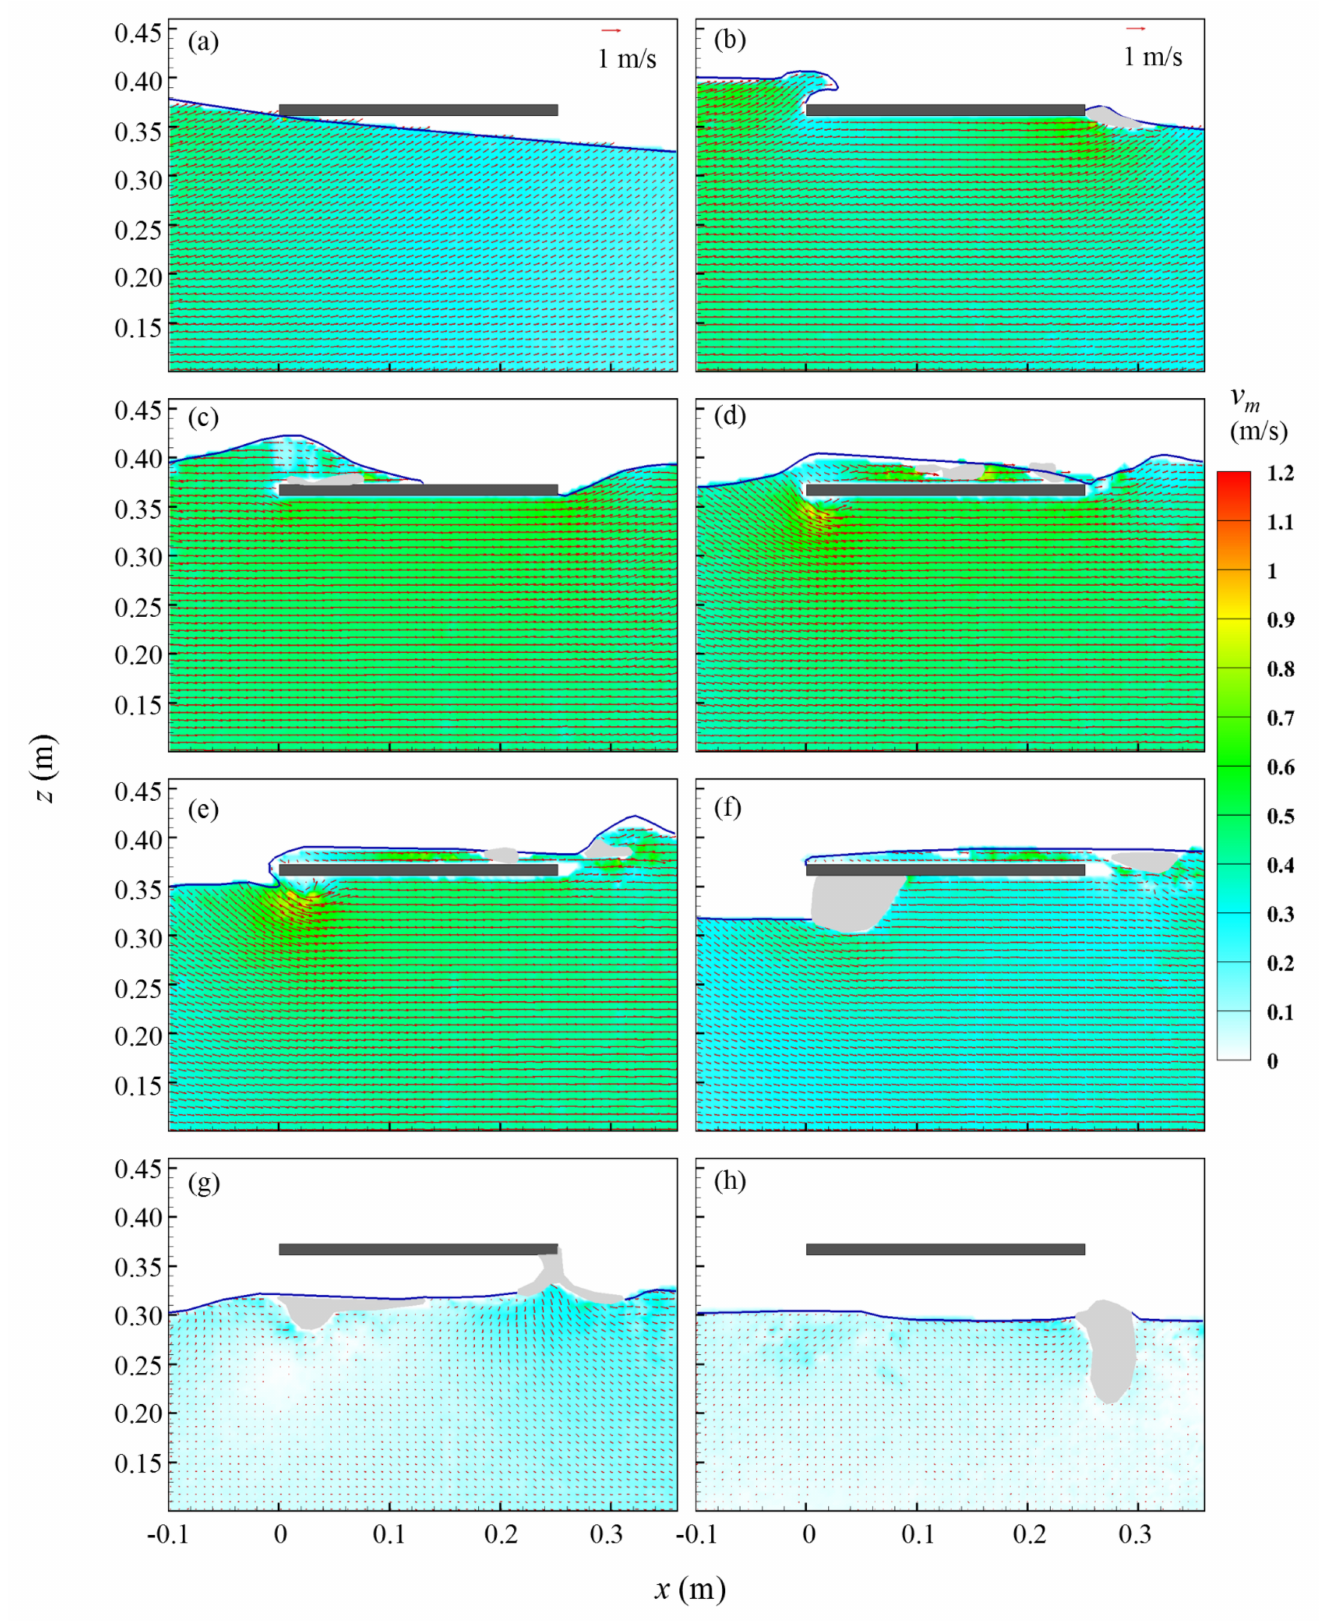
Figure 3. Measured velocity fields around the plate on the side view of Case 1, D / h = 6/30, H / h = 10/30. T = ( a ) 0; ( b ) 0.17; ( c ) 0.42; ( d ) 0.62; ( e ) 0.74; ( f ) 0.95; ( g ) 1.45; and ( h )